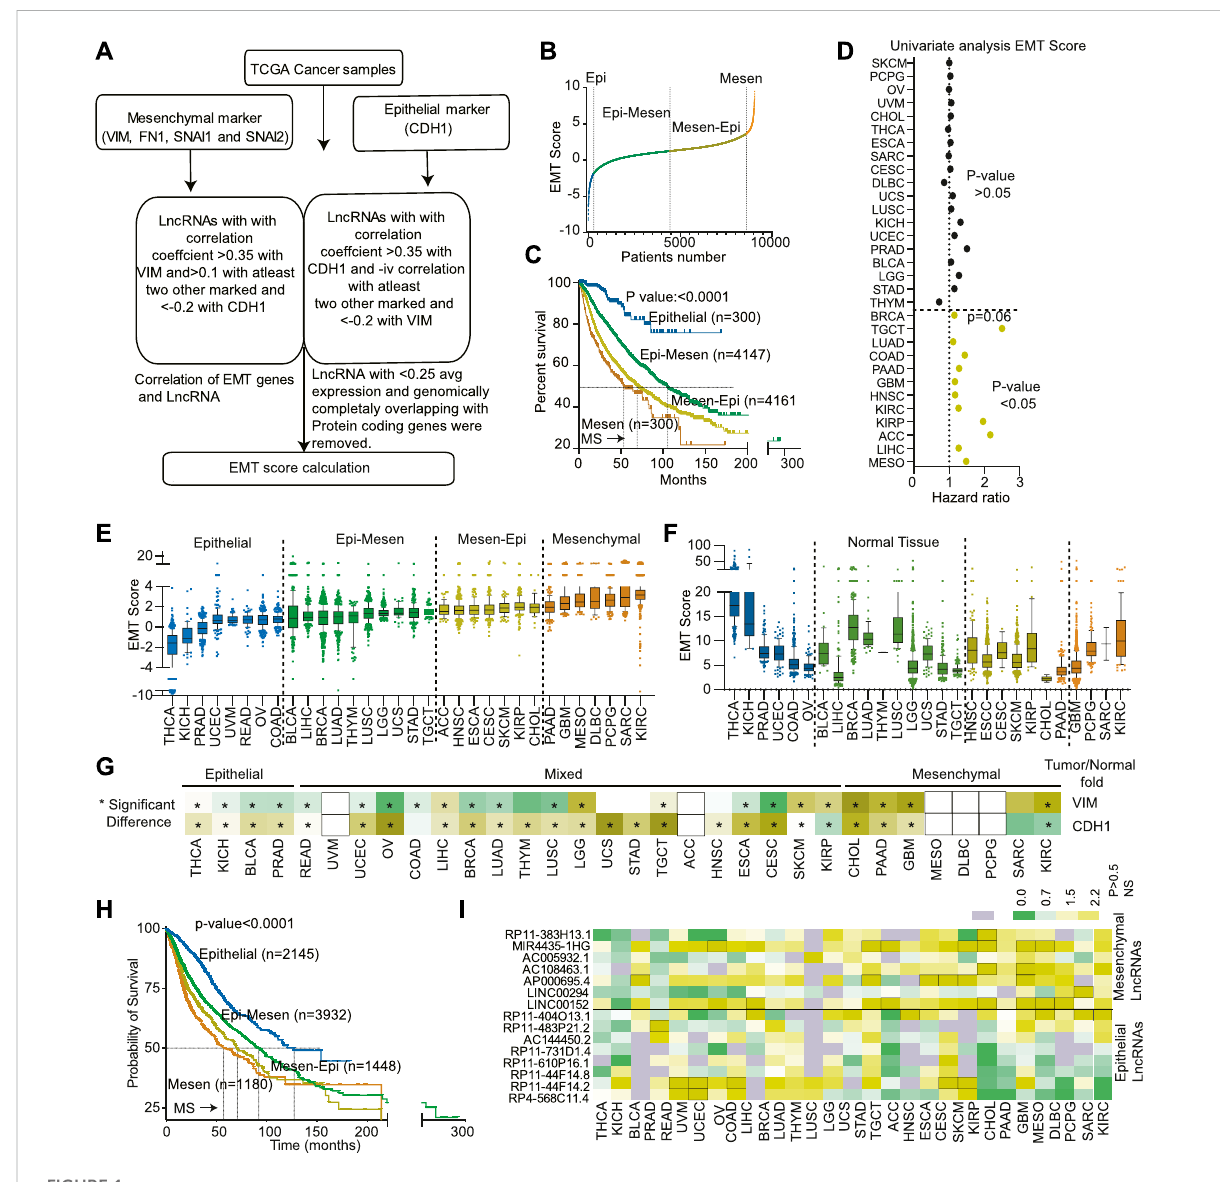
Classi fi cation of 32 cancer types based on EMTness: (A) A fl ow chart showing the steps used to identify the EMT-related LncRNAs. (B) An EMT scorewasdevelopedforeachTCGAcancerpatientusingtheformuladescribedinthemethodsection.Theplotshowsthedivisionofcancerpatients into Epithelial (Epi), Epithelial-Mesenchymal (Epi-Mesen), Mesenchymal-Epithelial (Mesen-Epi), and mesenchymal groups. (C) The Kaplan- Meier plot showing the differences in survival of the four EMT groups. (D) EMT score for each cancer type was used to perform the univariate Cox- regression analysis. The Hazard ratio and p -value are depicted. (E) The EMT score for 32 TCGA cancer types were plotted in increasing order of average EMT score for each cancer type. The cancer types were then divided into four EMT groups. (F) The EMT score for normal samples was calculated and plotted to show an association between cell origin and EMTness of cancer. (G) Expression of VIM and CDH1 was compared between normal and tumor of each cancer type and plotted as a heatmap. Yellow is associated with increased expression, and green is associated with decreased expression. * indicates the signi fi cant comparisons. (H) The survival of cancers based on EMTness, as identi fi ed in Figure 2E, compared using the Kaplan-Meier plot. (I) The fold change in expression between normal and cancer of each of the 14 LncRNAs was calculated and plotted. Green indicates signi fi cant decreases, and yellow indicates a signi fi cant increase in expression in the tumor compared to normal. The grey indicates non-signi fi cant differences in